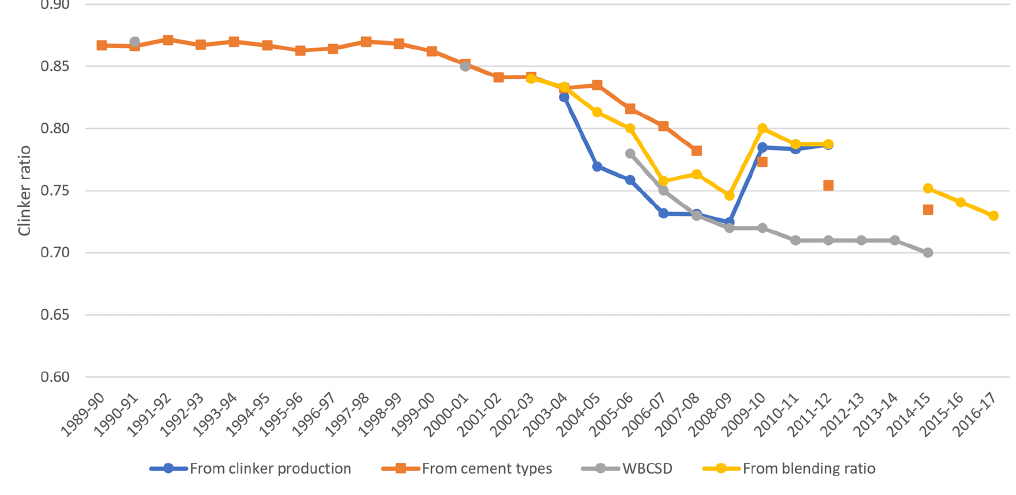
Figure C5. Estimates of clinker ratio in India from various sources.